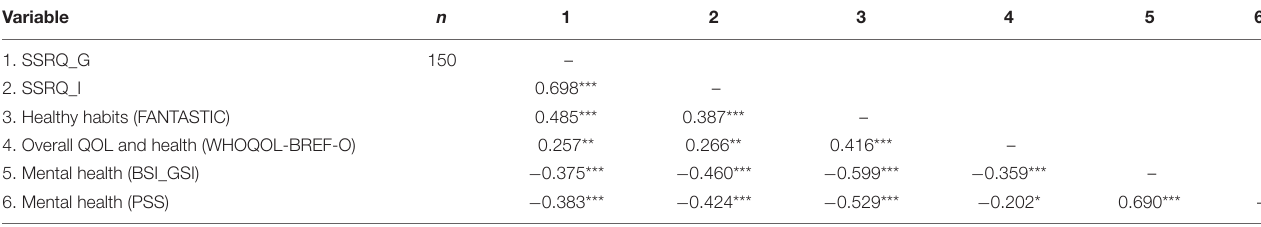
TABLE 2 | Partial correlations controlled for age, gender and weeks of confinement. Variable